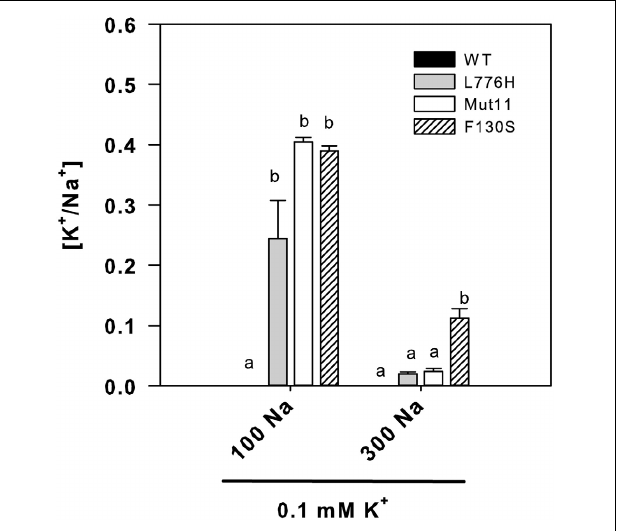
FIGURE 3 | Internal K + /Na + ratios of 9.3 yeast cells expressing WT AtHAK5 and mutated AtHAK5 K + transporters. Cells were treated and analyzed as indicated in Figure 2 . Shown are the ratios of internal K + /Na + concentrations of the cells grown in the presence of 0.1mM K + at 100 or 300mM Na + . Reported values are the average of at least 6 replicates and error bars denote standard error. Columns with different letters within each ionic treatment are significantly different according to Tukey test ( p < 0 .